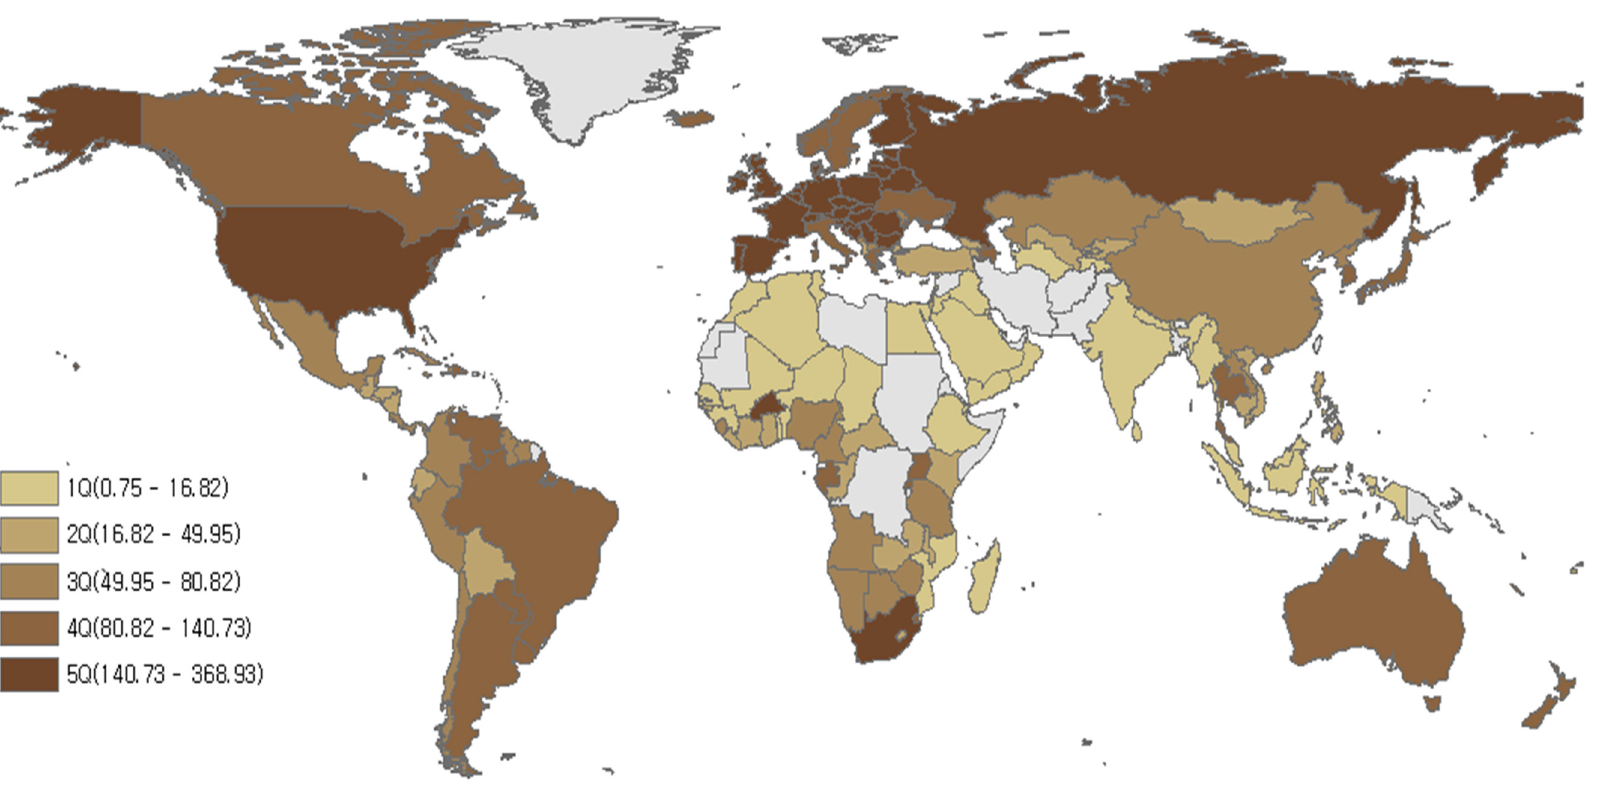
Figure 4. Alcohol consumption (kcal/capita/day) in 164 countries from 1992–2013. Grey areas have no data.